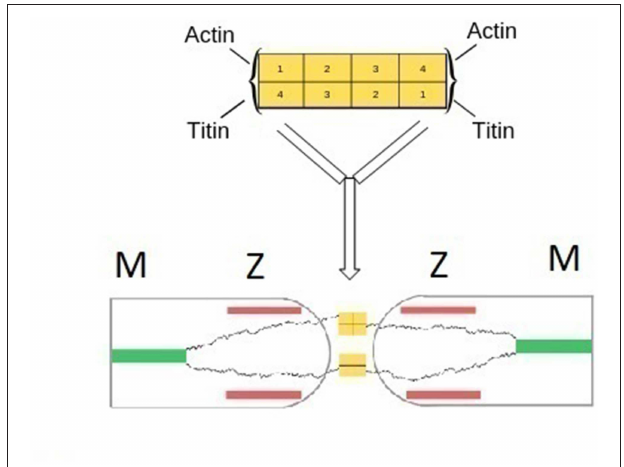
FIGURE 3 | (Top) Schematic representation of the structure of α -actinin based on a rod-like dimer of four antiparallel rigid spectin-like domains. Binding of actin or tinin filaments occur at each end of the dimer (Grison et al., 2017). (Bottom) Schematic representation of the fusion of two Z-zones of neighboring half sarcomers and the formation of main-chain titin bonds. α -actinin bridges titin terminals of two adjacent sarcomers. Bridges between titin and actin filaments are omitted for